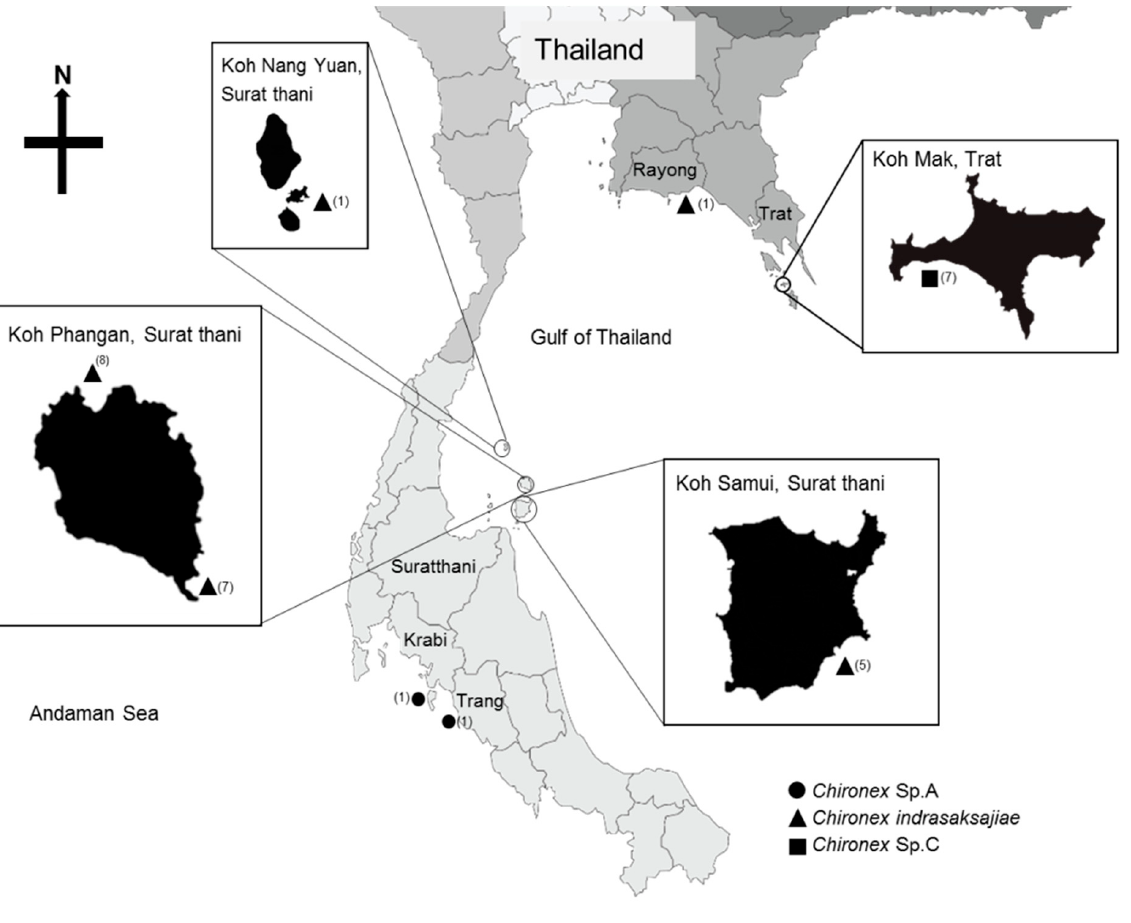
Figure 1. Map of Thailand, showing the species and locations where Chironex samples used in this study were found. The numbers in the bracket are animal numbers collected from each location.